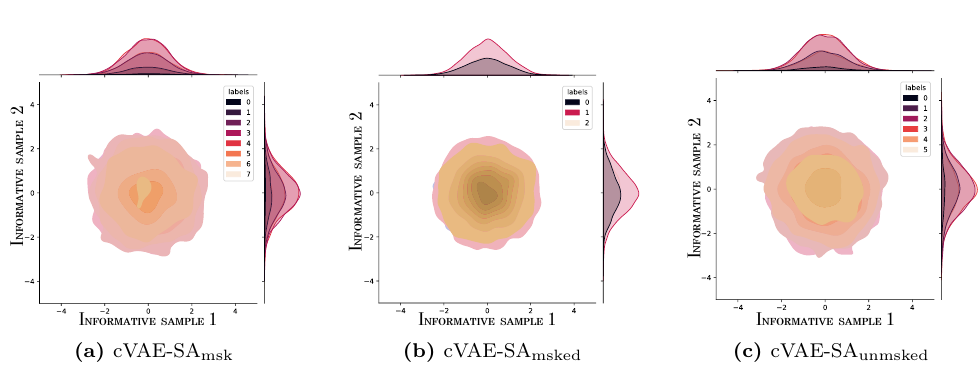
Figure 13: Distribution of the latent space depending on the targeted sensitive